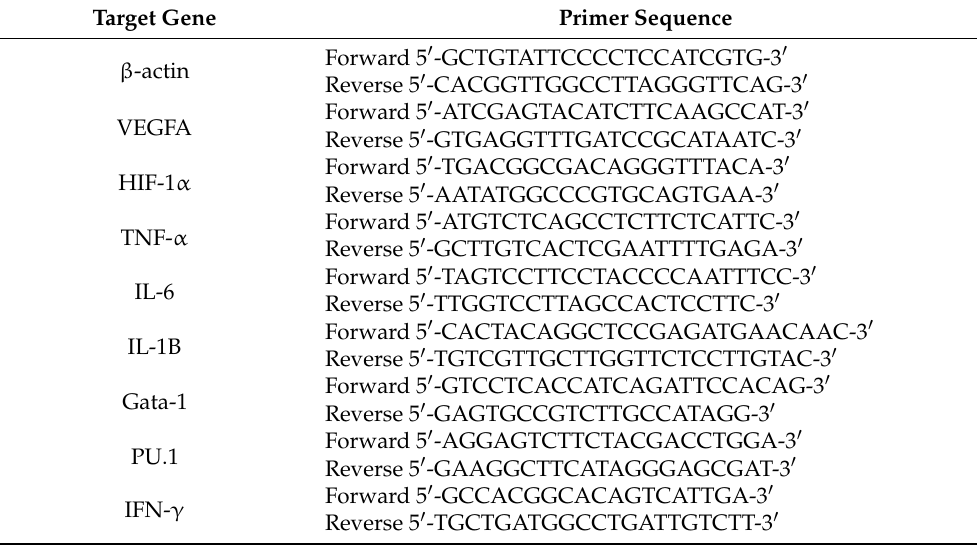
Table 1. The primer sequences of